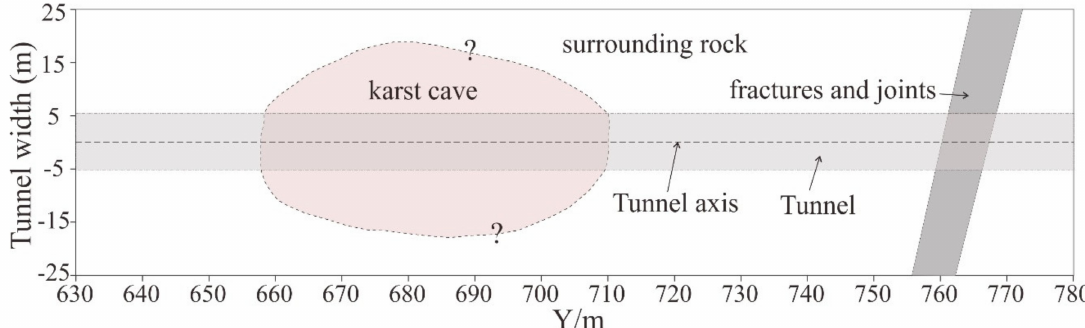
Figure 15. Geological interpretation map. The left and right extension boundary of the karst cave cannot be determined